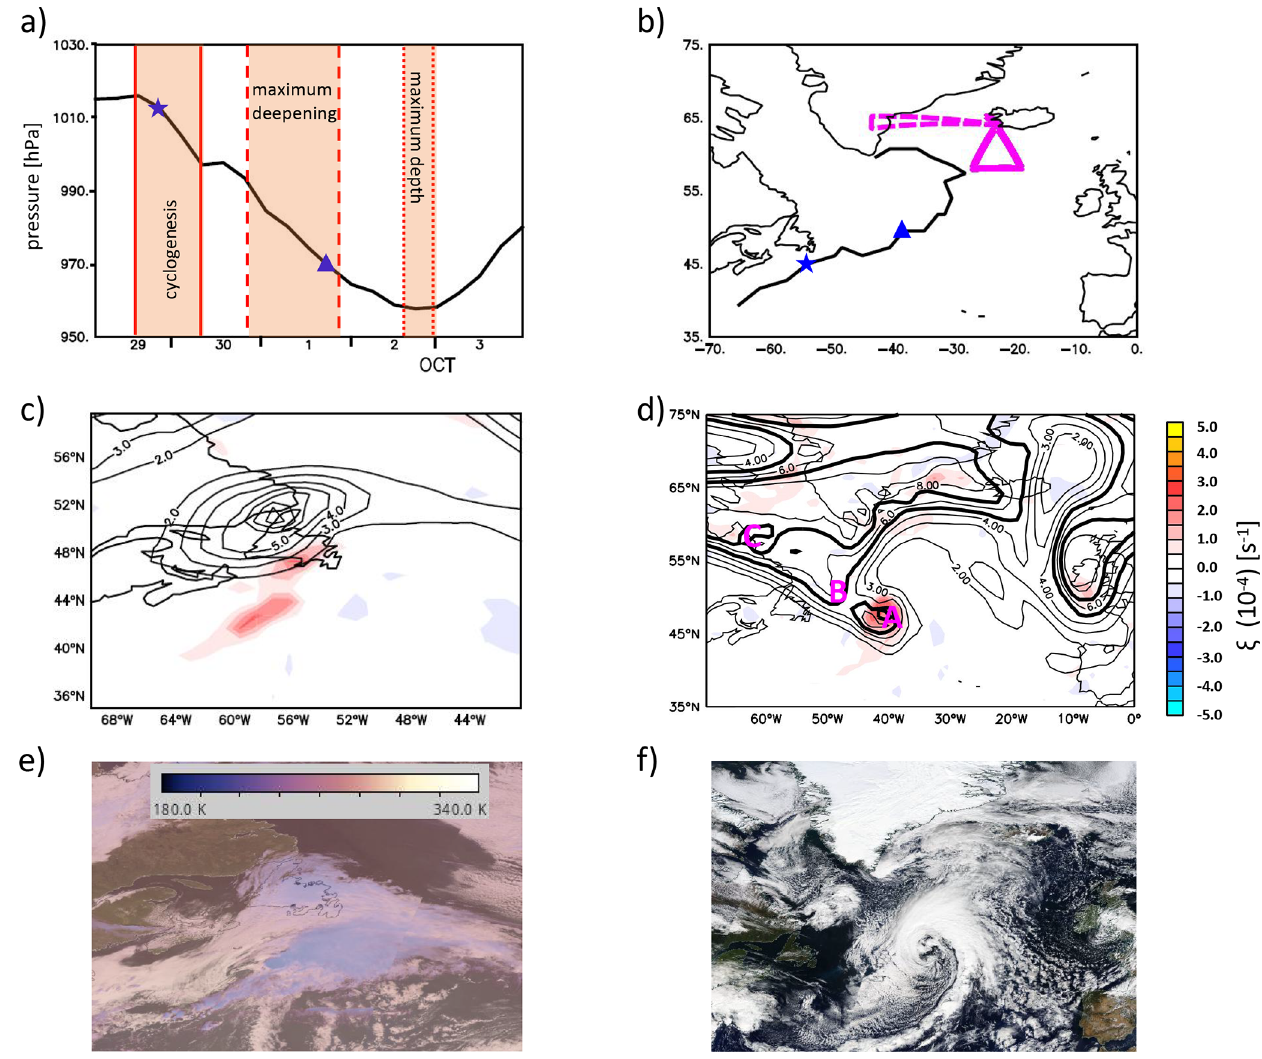
Figure 1. An overview of the Stalactite cyclone. (a) The ECMWF analysis minimum pressure evolution. (b) The track of the Stalactite cyclone (black). The dashed magenta line is the flight path of SAFIRE Falcon-20 flight 6 and the solid is for flight 7. The star and triangle in (a) and (b) represent the timing of panels (c) and (e) and (d) and (f) , respectively. (c) The ECMWF analysis of the 250hPa PV > 2PVU (contoured) and 850hPa relative vorticity (shaded) at cyclogenesis (18:00UTC 29 September), and (d) is like (c) but just before maximum deepening at 12:00UTC 1 October. The bold lines are to indicate the PV signature of different PV regions interacting with the cyclone. “A” is the upper-level signature of the Stalactite cyclone at that time, “B” is the second PV region to interact with the cyclone, and “C” is the third. The colour scale applies to both (c) and (d) . (e) A visible satellite image from MODIS on 29 September indicating the Stalactite cyclone at cyclogenesis. The brightness temperature has been overlaid and saturated at 50%. (f) The visible satellite imagery from MODIS on 1 October 2016. The satellite images are produced by courtesy of NOAA Worldview (https://worldview.earthdata.nasa.gov/, last